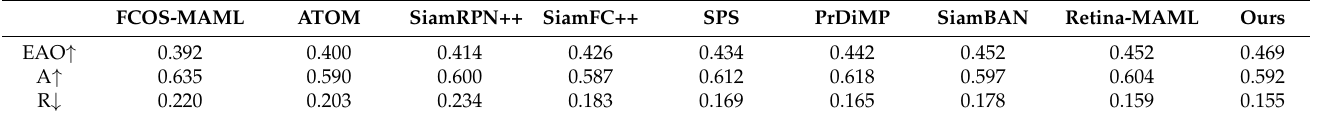
Table 2. Performance comparisons on VOT2018 benchmark.